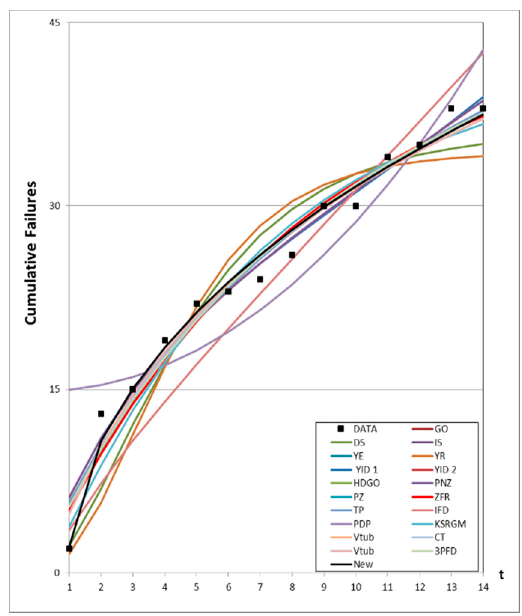
Figure 1. Mean value functions for all models in Table 1 for dataset #1.